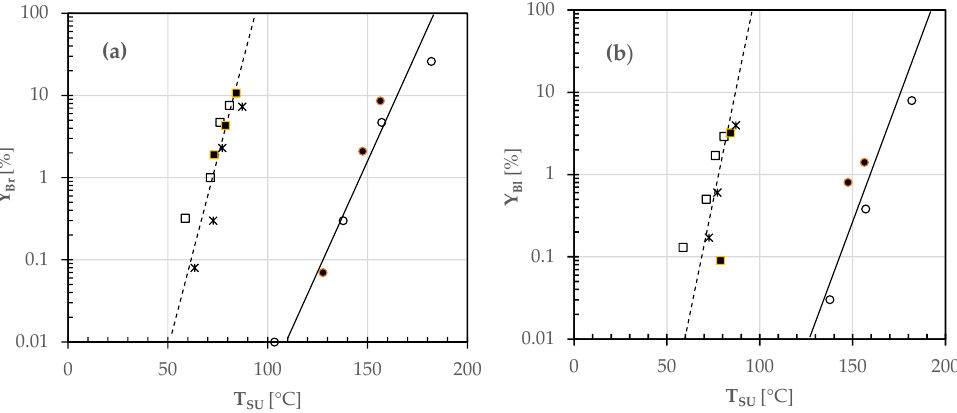
Figure 8. Semilogarithmic plot of the percentage degree of ( a ) browned (Y Br ) and ( b ) blackened (Y Bl ) areas of the upper surface area of different pizza samples (A: ; B: • ; C: (cid:3) ; D: (cid:4) ; E: ∗ ) during baking in a wood-fired oven versus the corresponding temperature (T SU ). The continuous and broken lines were the least squares regression lines estimated using Equation (2).